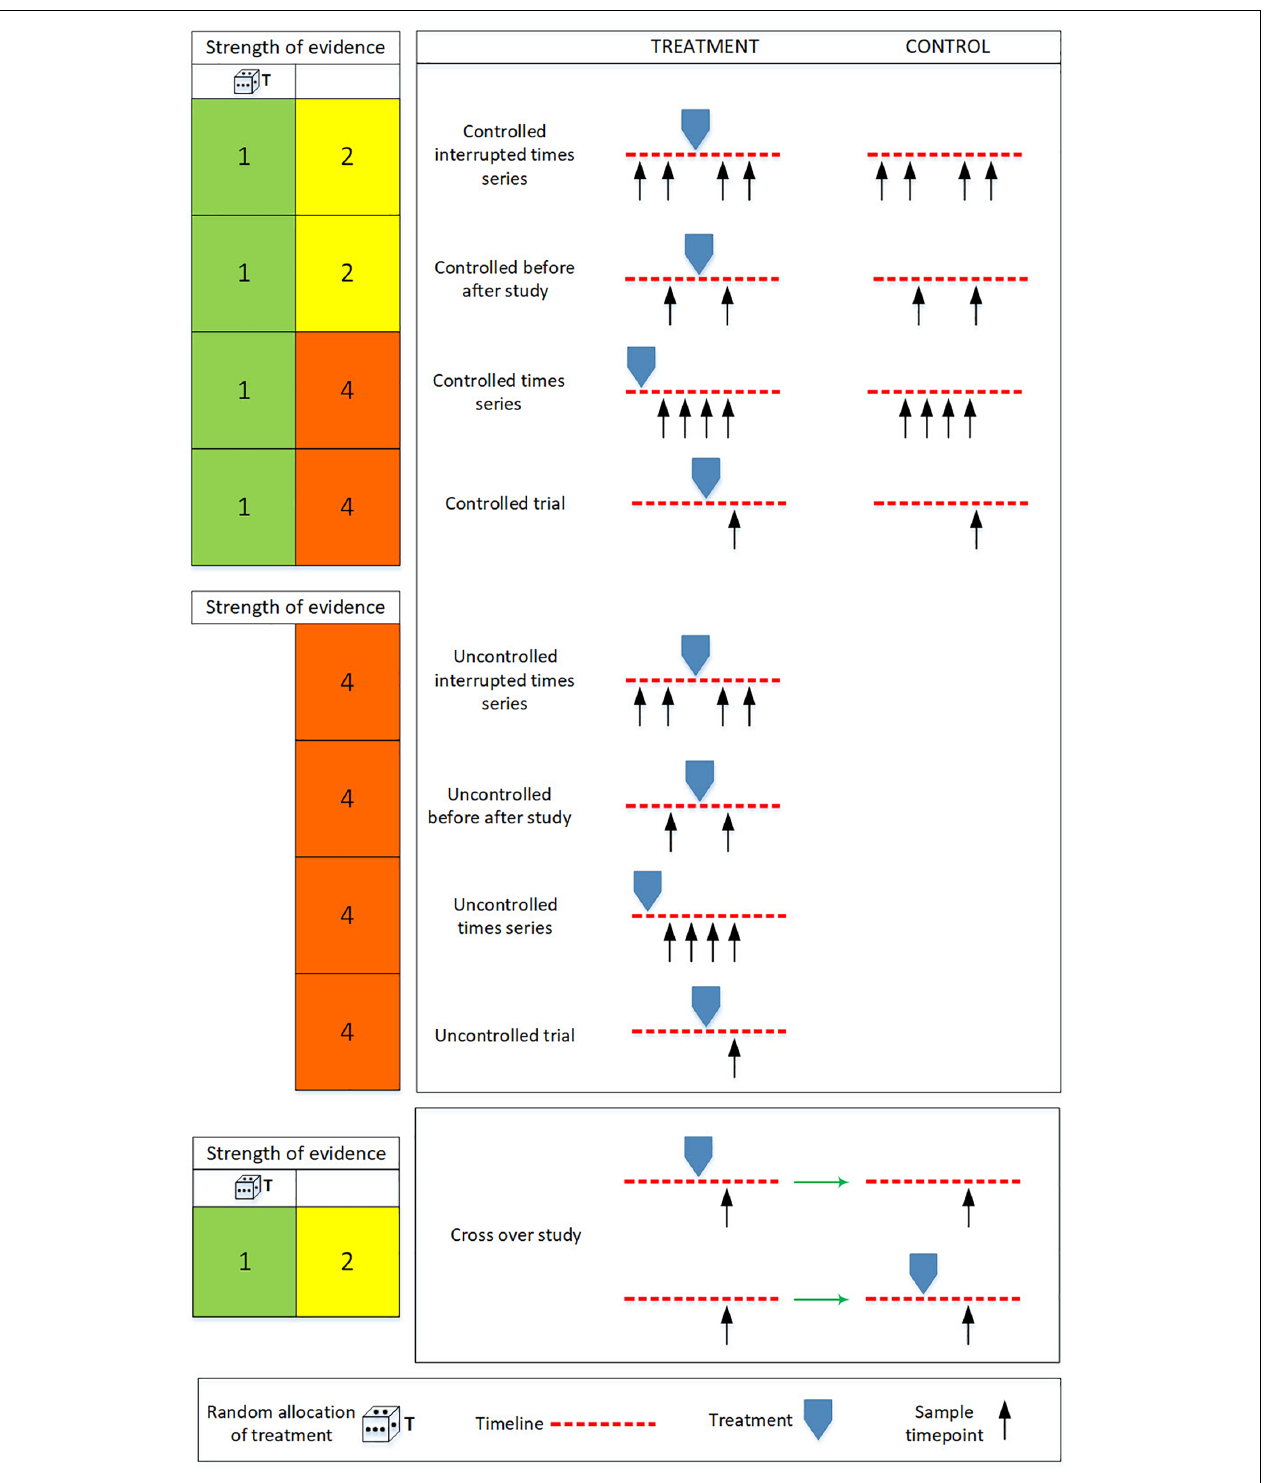
FIGURE 2 | Schematic illustration of the evidence hierarchy for randomized controlled trials, non-randomized controlled trials and cross over studies. The die represents randomization at the level of treatment. The strength of evidence is always stronger with treatment randomization (first column on the left) than without it (second column on the left). The colors in the columns to the left reflect the evidence hierarchies presented in Figure 1 . The strength of evidence is ranked from highest (1) to lowest (5). The “treatment” in this context could be the designation of a new MPA, a change in zonation status, or the implementation of new education or compliance regime ( Table 1 ). The figure is adapted from Wilson et al. (2015) who adapted Walshe et al. (2013).